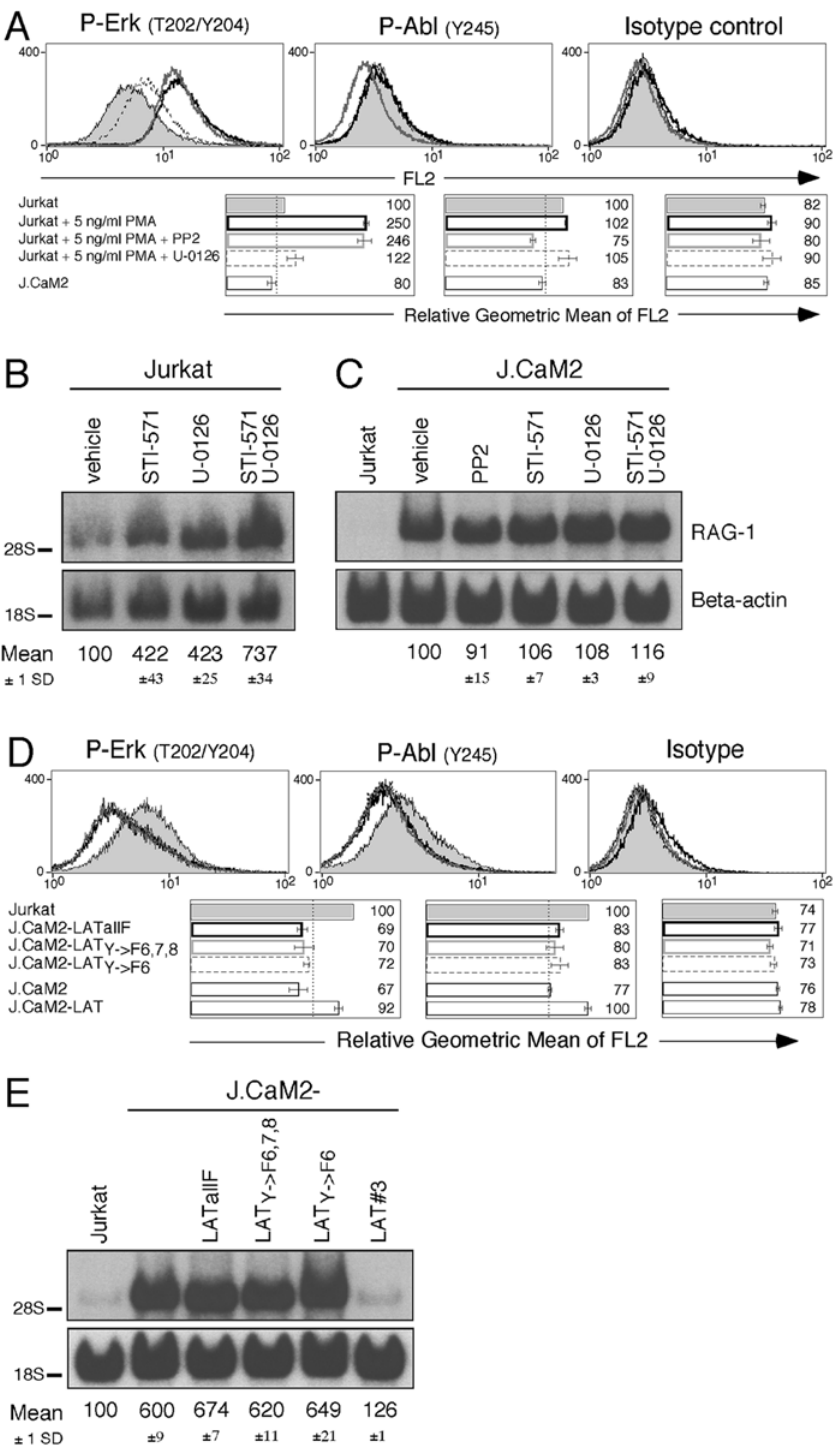
Figure 7. Erk and Abl Synergize to Repress RAG-1 Expression and Require Tyrosine 132 in